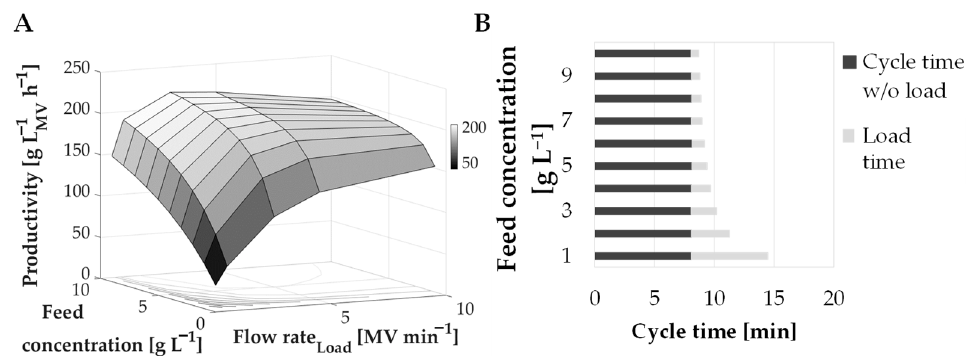
Figure 6. DBC 10% as a function of residence time for several commercially-available materials and the convecdiff membrane prototype. The convecdiff membrane prototype (1.2 mL MV and 4 mm bed height), as well as some of the other membranes/materials were tested internally. All other data points are taken from competitor [6,10,11].